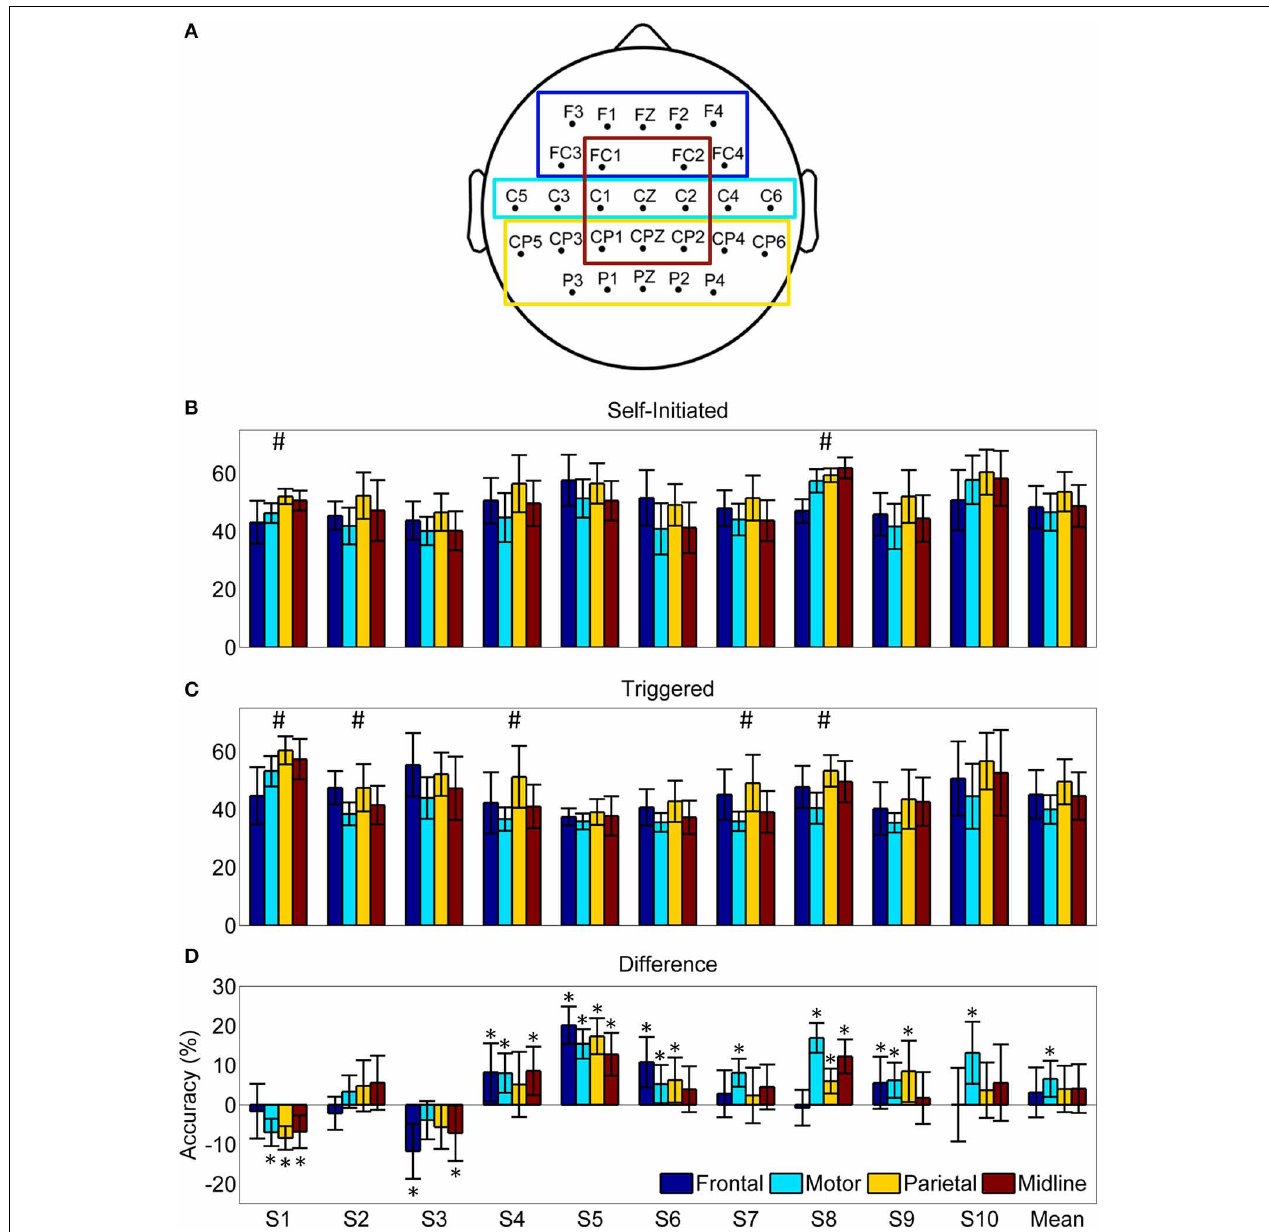
FIGURE 10 | Pre-movement decoding accuracy by region of interest (ROI). (A) Scalp map indicating the electrodes included in each ROI. (B) Average decoding accuracy ± 1 standard deviation ( n = 20) using the optimized LFDA-GMM algorithm for each ROI and subject during the self-initiated condition. (C) Average decoding accuracy ± 1 standard deviation ( n = 20) using the optimized LFDA-GMM algorithm for each ROI and subject during the triggered condition. Hash marks